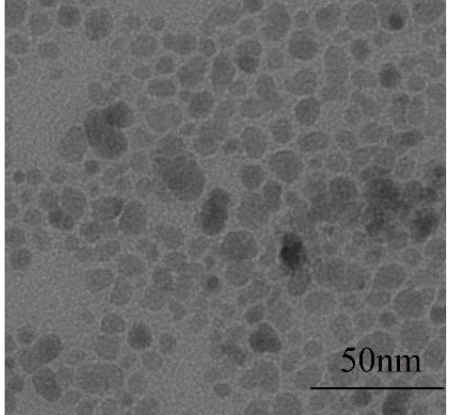
Figure 5. TEM image of the magnetic nanoparticles.